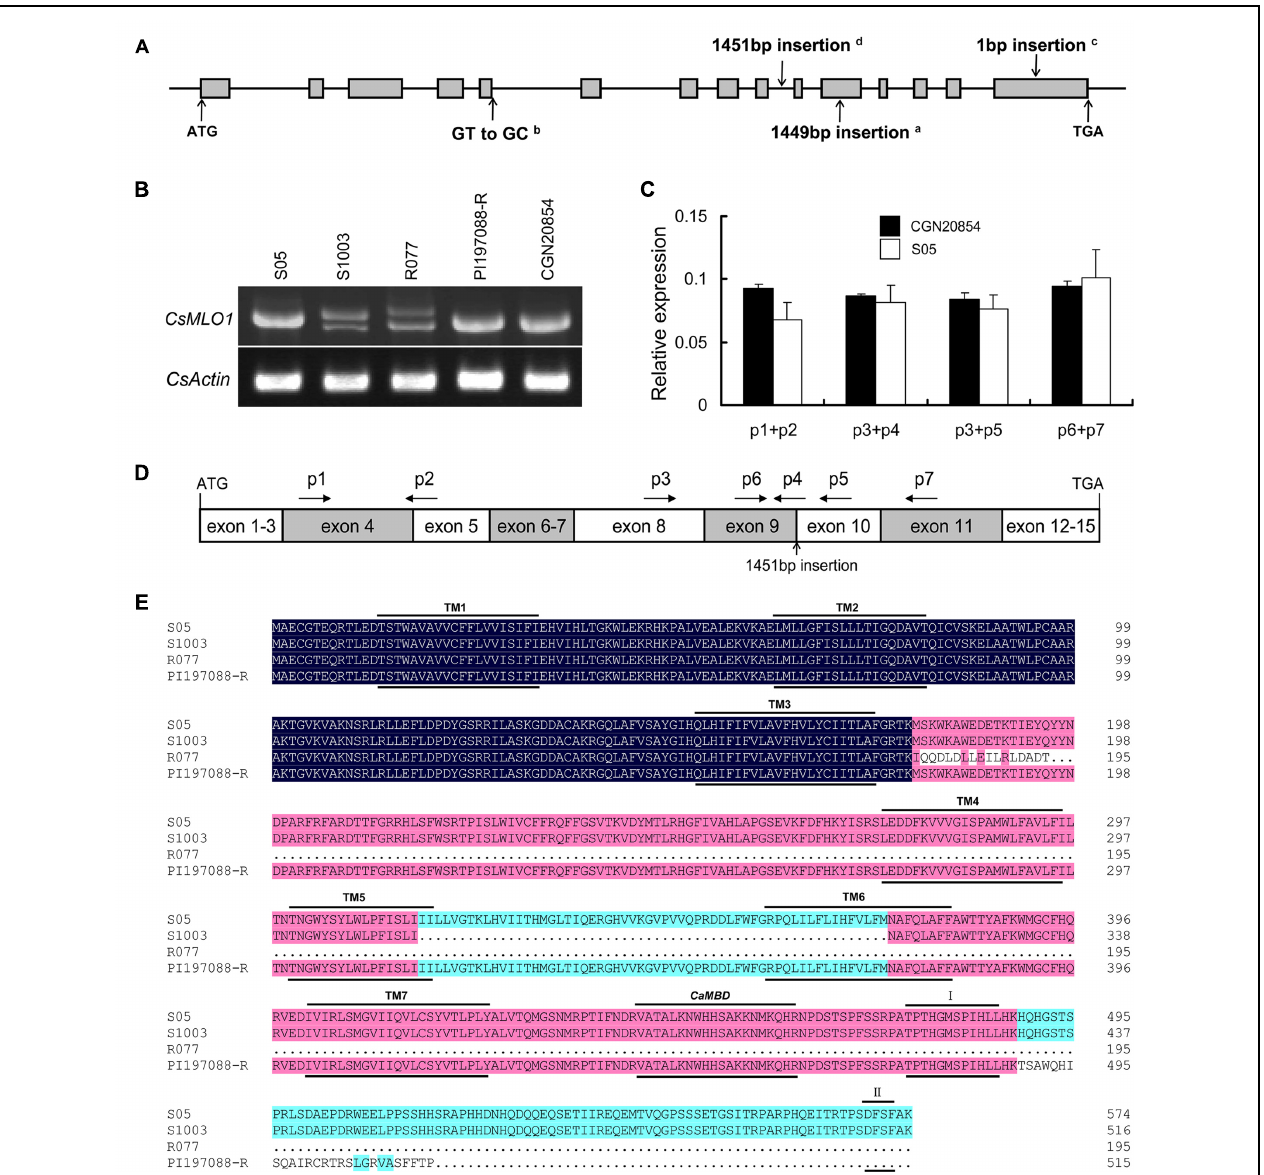
FIGURE 5 | Variant alleles of CsMLO1 and their effects on the transcripts and proteins. (A) Gene structure and haplotype analysis of CsMLO1 . Gene structure is shown using the CsMLO1 gene sequence of S05 as a reference. Gray boxes and lines between them denote exons and introns, respectively. The mutation types in the different resistant cucumber lines and susceptible line CGN20854 are indicated by arrows. a The 1449-bp insertion mutation in the S1003-like haplotype (haplotype A); b the splicing site mutation from GT to GC in the R077-like haplotype (haplotype B); c the 1-bp insertion mutation in PI197088-R (haplotype C); d the 1451-bp insertion mutation in CGN20854. ATG, start codon; TGA, stop codon. (B) Identification of transcript variations by expression analysis via RT-PCR, focusing on the entire coding transcript. (C,D) Confirmation of the expression levels of the CsMLO1 allele in line CGN20854 by qRT-PCR using different